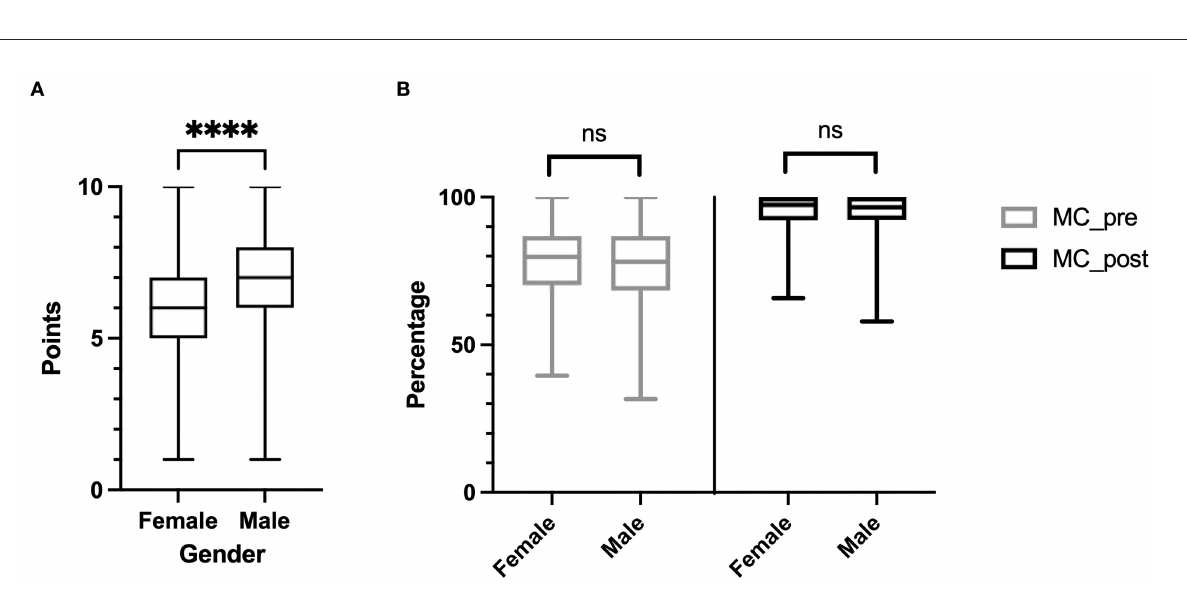
FIGURE2 Gender differences. Male students self-rated their confidence in performing a sufficient resuscitation significantly higher (A) . There were no gender differences in the median percentage of correctly answered multiple-choice test questions performed before (MC_pre) and after